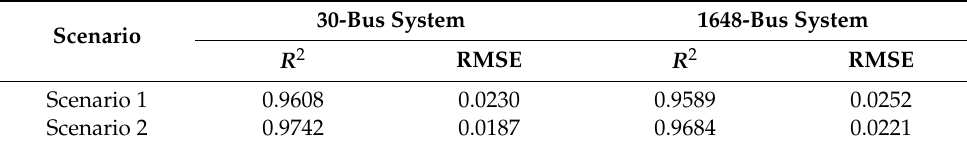
Table 4. Assessment accuracies considering PMU measurement errors.